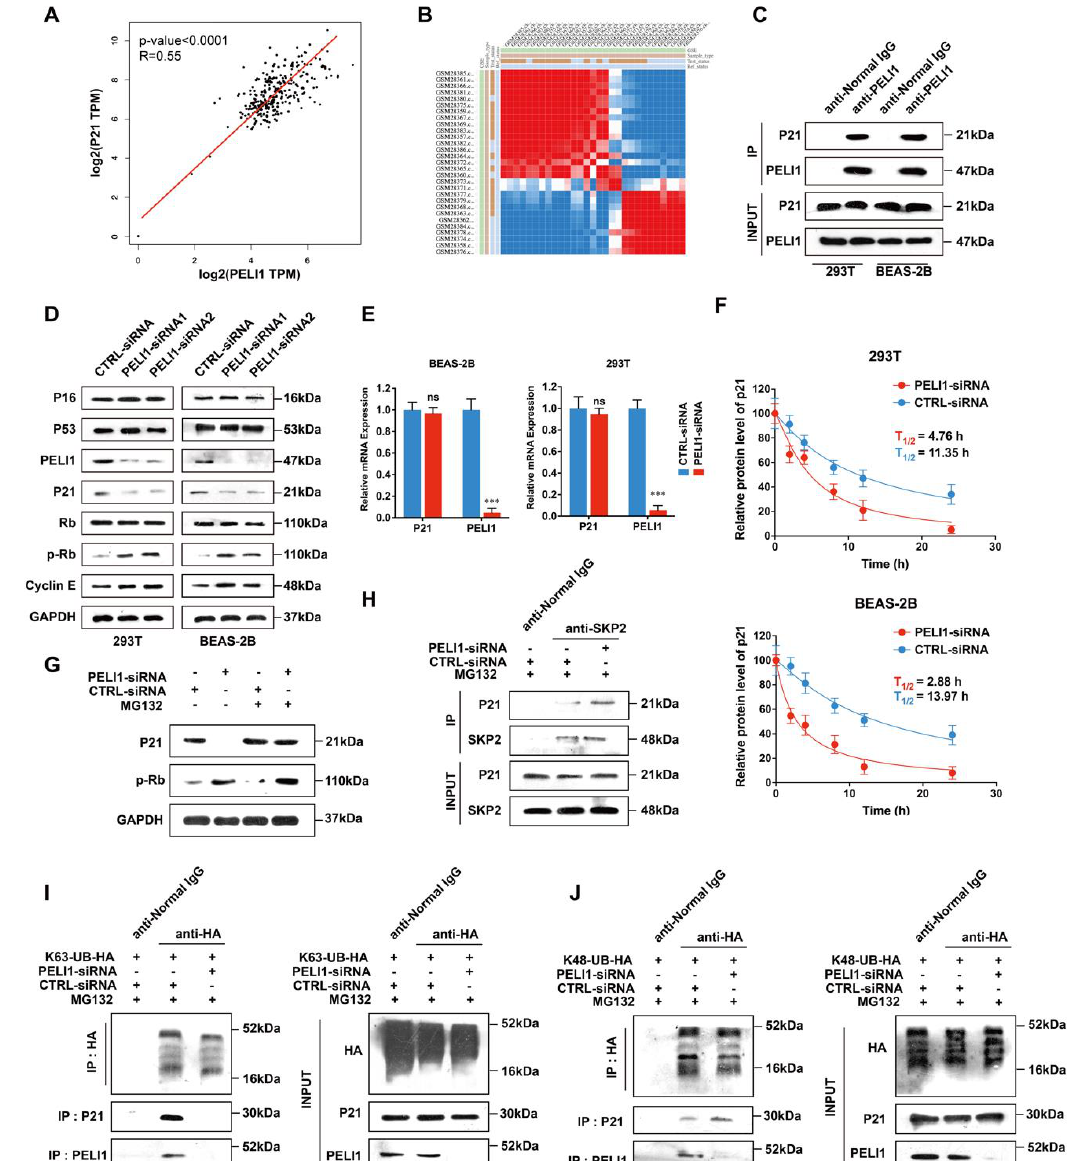
Figure 1. Pellino-1 regulates the degradation of p21 via K63-site ubiquitination. ( A ) The relationship between PELI1 and p21 was significant in the GTEx-lung database (Data represents R for relative coefficient and P for significance). ( B ) The column similarity matrix of PELI1 and p21 in COPD study GSE1650 showed a positive relationship in both COPD and healthy patients (Matrix values: pure blue for − 1, pure red for 1). ( C ) Co-IP of PELI1 and p21 showed an interaction between PELI1 and p21 in both 293T and BEAS-2B cells (n = 3). ( D ) In 293T and BEAS-2B cells, two kinds of siRNAs of PELI1 both led to an increase in phosphorylated Rb and Cyclin E1 and a decrease in p21. P16, P53 and unphosphorylated Rb did not change significantly (n = 3). ( E ) The mRNA expression changes in p21 after siPELI1 did not change significantly. Data represent mean ± SEM; *** p < 0.001, ns for not significant (n = 3). ( F ) Quantitative analyses of p21 degradation in BEAS-2B and 293T cells after silencing of PELI1 following treatment with CHX (10 µ g/mL). The half-lives (T 1/2 ) of p21 degradation were calculated by single-phase decay analysis (n = 3). ( G ) Treatment with MG132 (5 µ g/mL) and silencing of PELI1 led to an increase in p-Rb and did not change p21. ( H ) Co-IP assay showed that silencing PELI1 led to the enhanced combination of p21 and SKP2 (n = 3). ( I , J ) HA-tagged K48 and K63 ubiquitination sites were constructed. Silencing PELI1 led to a decrease in K63-Ub and an increase in K48-Ub combined with p21 (n = 3). Figure S1 is related to Figure